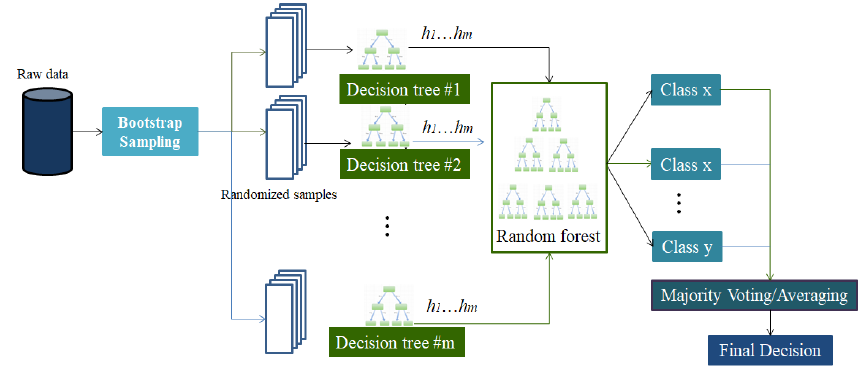
Figure 3. RF algorithm.